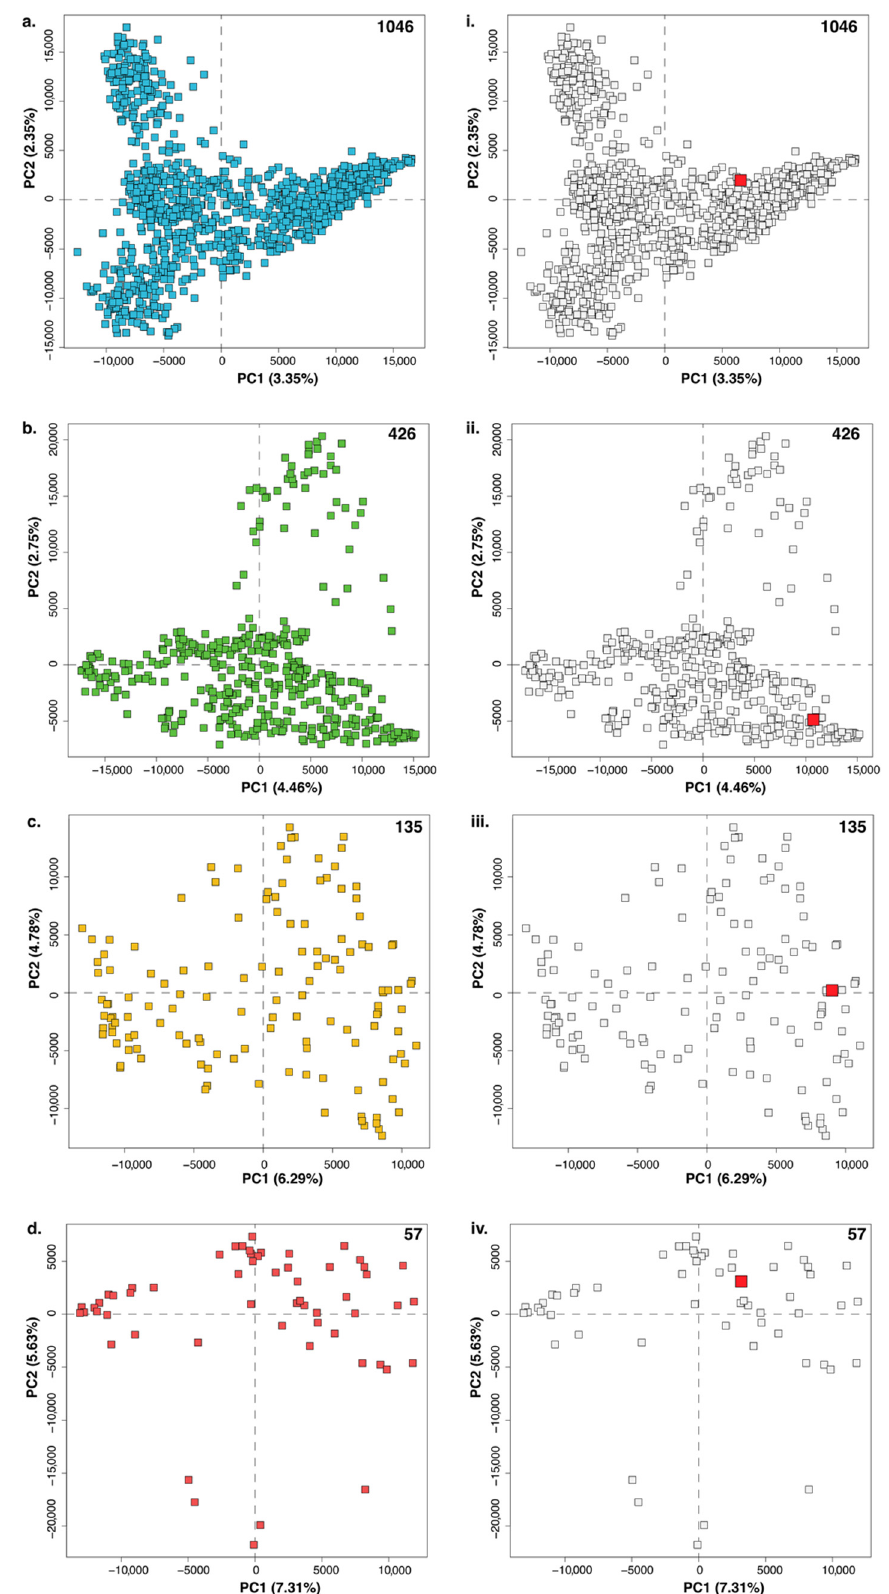
Figure 5. ( a – d ) represent the PCA models for the nodes mw, yq, ss, and bm from Figure S2, respectively. Sub-plots ( i – iv ) correspond to ( a – d ), respectively, highlighting the position of A1901 using a red dot while de-emphasizing other points in the plot by making them grey. Without the utilization of hcapca , the discovery of the new anticancer compounds would not have been possible.